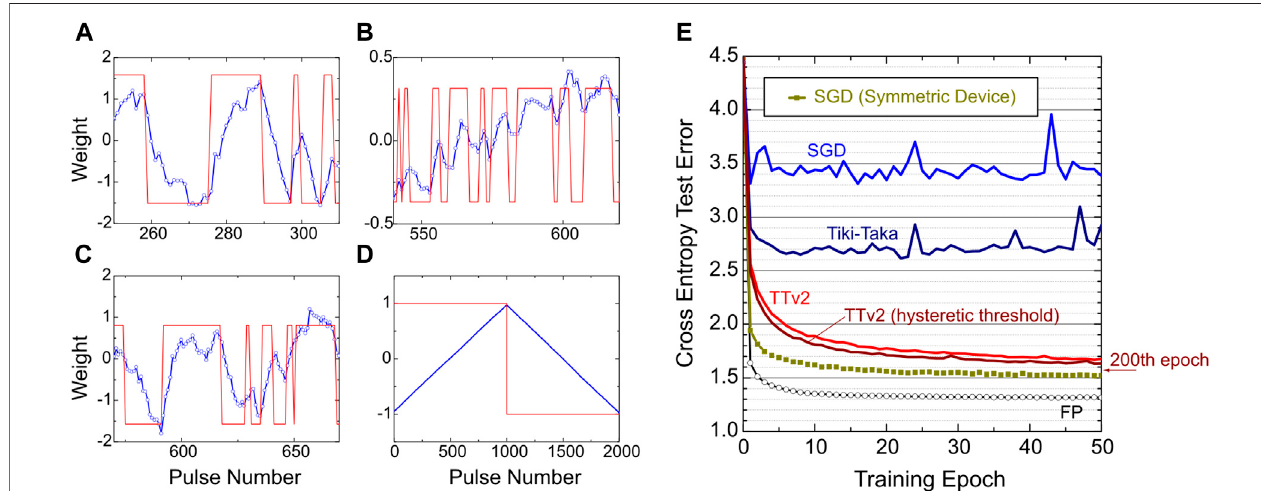
FIGURE 5 | (A, B, C) Blue curves: The evolution of three different weights (corresponding to three different devices with non-symmetric behavior, σ cycle (cid:1) 1 and about 15 states) during TTv2 training. Red curves show the sign of the updates and the expected average saturation value for the corresponding device. (D) The evaluationofalinearandsymmetricdevicewith σ cycle (cid:1) 0 . 3andmorethan1,000states. (E) LSTMtrainingsimulationsforSGD,Tiki-Taka,andTTv2algorithms.Different colorcurvesuseanextremelynoisyarraymodelwithnon-symmetricdevices, μ Δ w (cid:1) 0 . 08(correspondingto15states),andtheadditivecycle-to-cycleupdatenoise with σ cycle (cid:1) 1.ThesquaresymbolsshowtheSGDtrainingbaselinefrom Figure3 withsymmetricdevicearrayswith1,200statesandcycle-to-cyclenoiseat σ cycle (cid:1) 0 . 3. The open circles are the fl oating-point